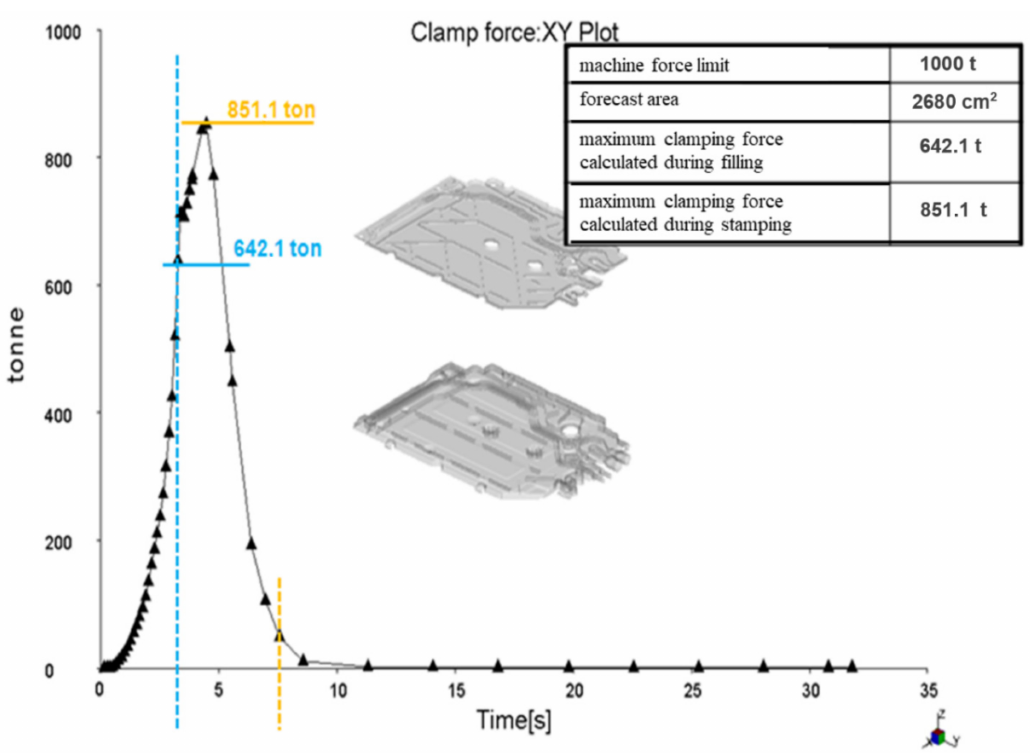
Figure 15. Clamping force